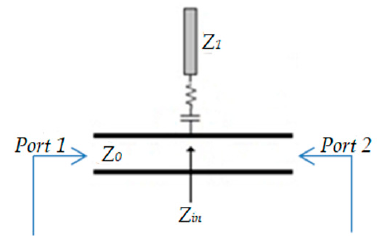
Figure 6. Coaxial resonator equivalent circuit.